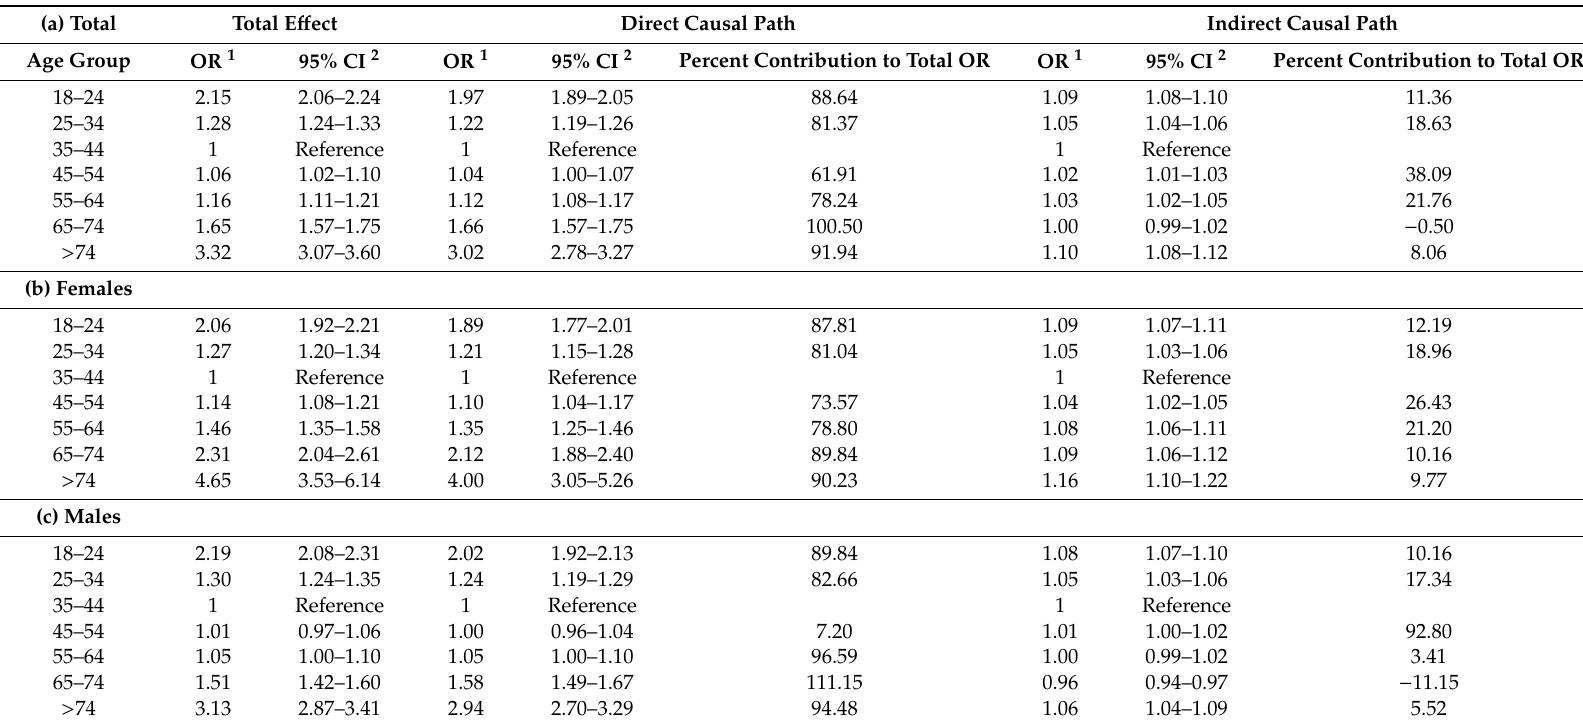
Table 2. Total OR, Direct Causal Path OR and Indirect Causal Path OR to estimate the association between each age group of drivers and the odds of causing a road crash, in the total sample and stratified by